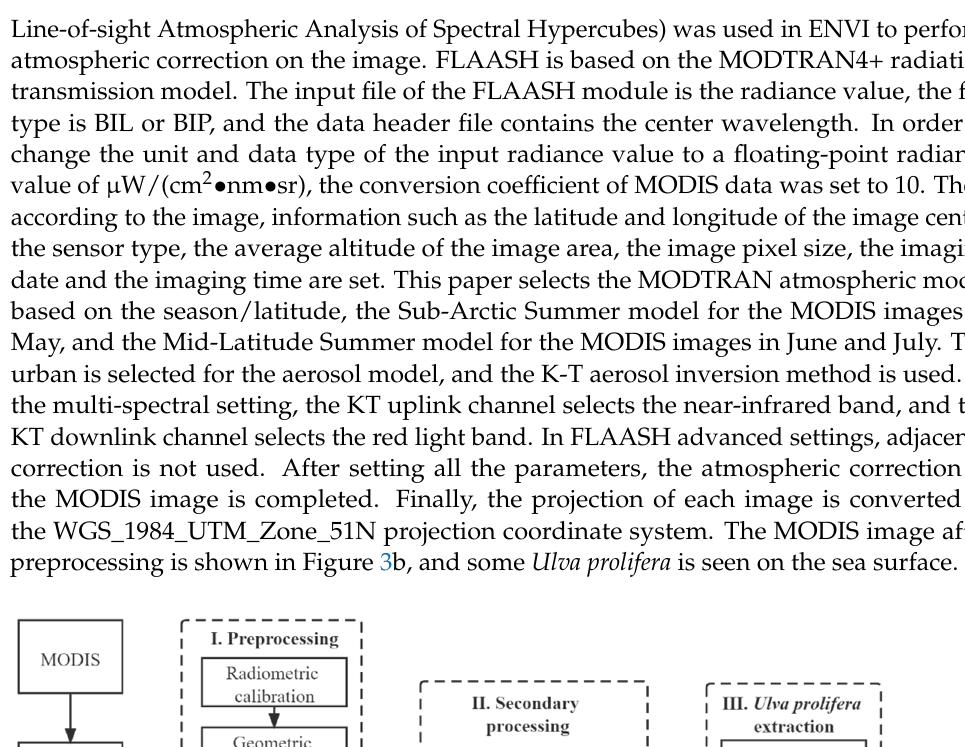
Figure 3. MODIS false color image on 4 June 2021. ( a ) MODIS image without pre-processing; ( b ) MODIS image with pre-processing.